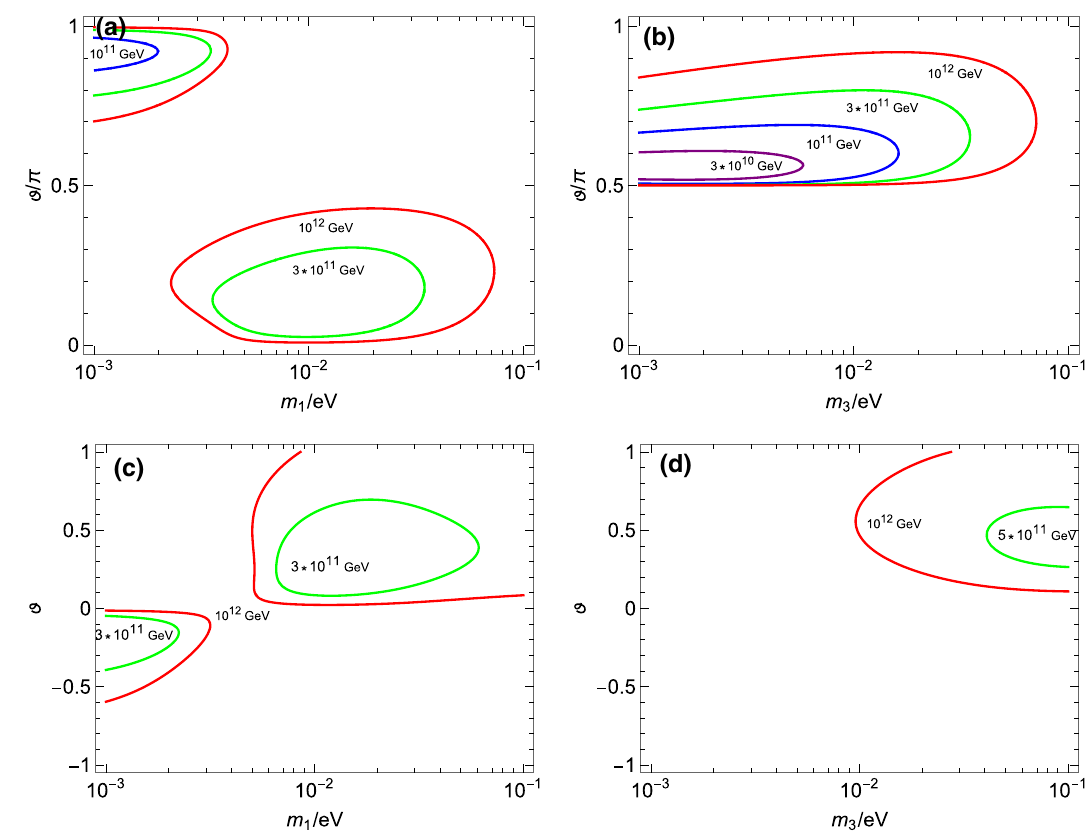
Fig. 7 Same as Fig. 5, expect that these results are for the case of M